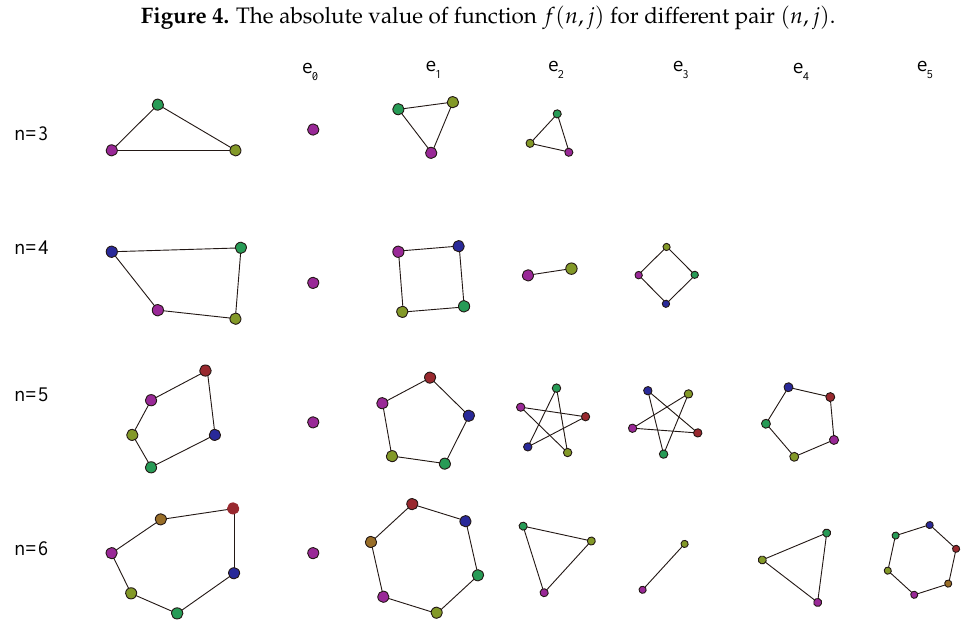
Figure 4. The absolute value of function f ( n , j ) for different pair ( n , j ) .